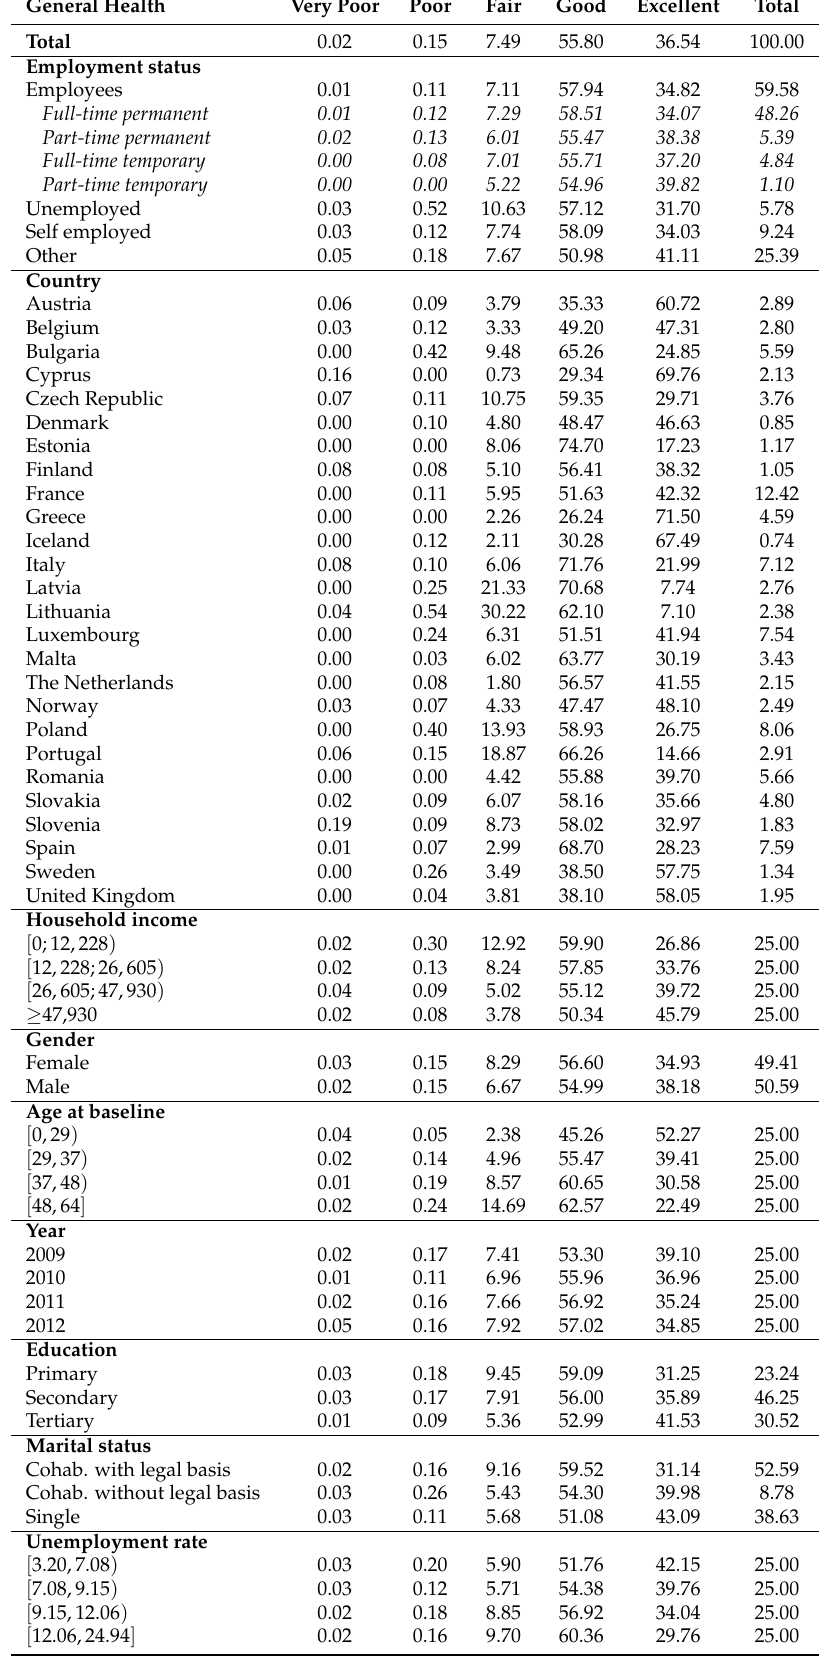
Table 1. Descriptive statistics for SHS (%) by total sample, employment status, country, household income (in classes), gender, age at baseline (in classes), year of interview, education level, marital